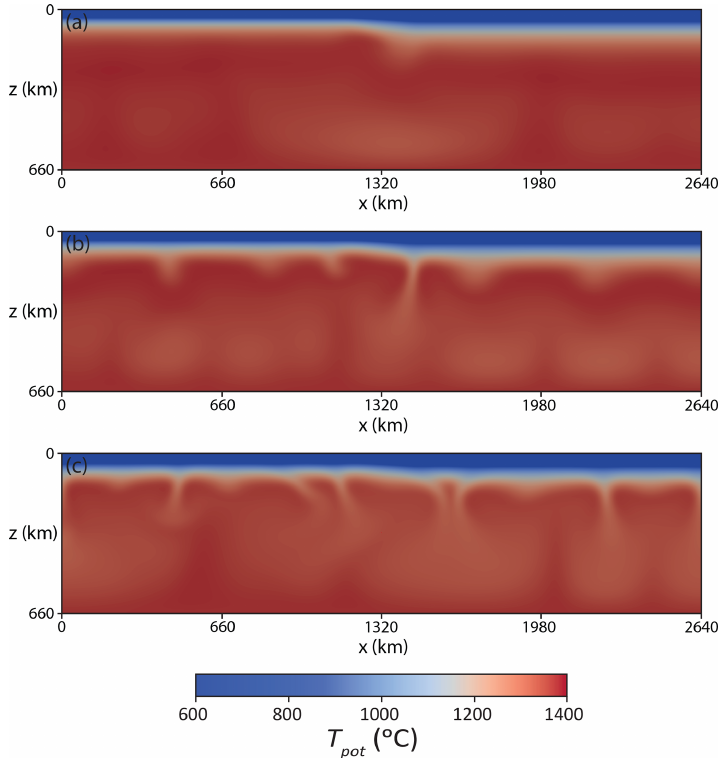
Figure A3. Vertical cross sections of a case without a plume perpendicular to plate velocities. (a) y = 220km; (b) y = 660km; (c) y = 1320km. Compared with Fig. 3 of Manjón-Cabeza Córdoba and Ballmer (2021), changes in time of EDC are well represented at depth, while plate velocities do not disrupt the general planforms of EDC.